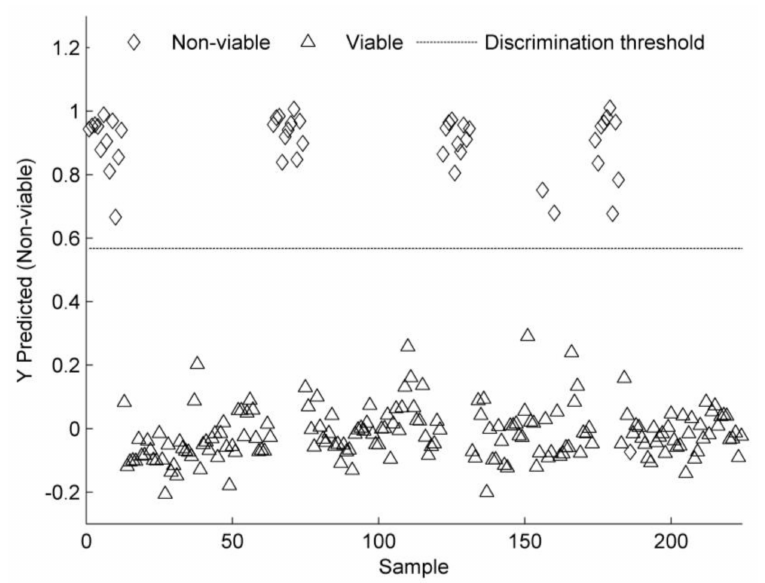
Figure 4. PLS-DA predictions for non-viable seeds. Values greater than the threshold value indicate class